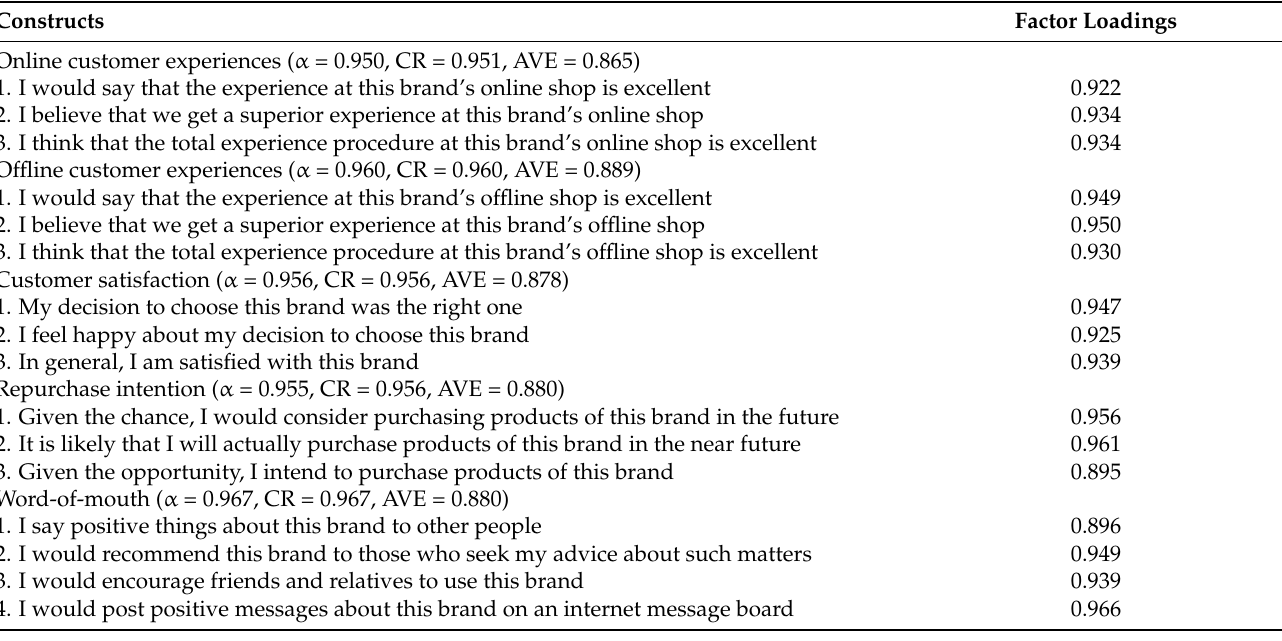
Table 2. Construct reliability and validity.